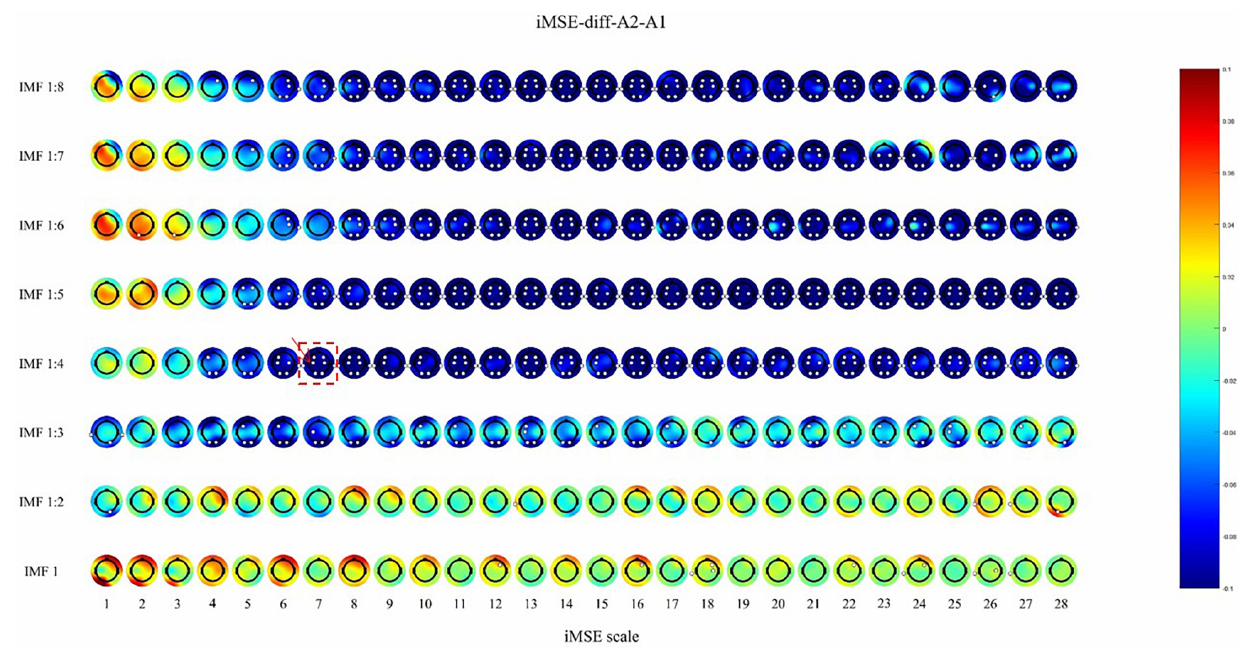
FIGURE 2 | The difference before and after active stimulation in iMSE for REM stage. Negative values indicate decreased iMSE after stimulation. The small white dots indicate significant differences ( p < 0.05). the color reflects the difference in the sleep EEG complexity before and after the stimulation. For example, the position where the color is blue, corresponding to –0.08 on the color bar, indicates that the EEG complexity decreased by 0.08 after stimulation. The white dots indicate that there is a significant difference ( p < 0.05) in EEG complexity.